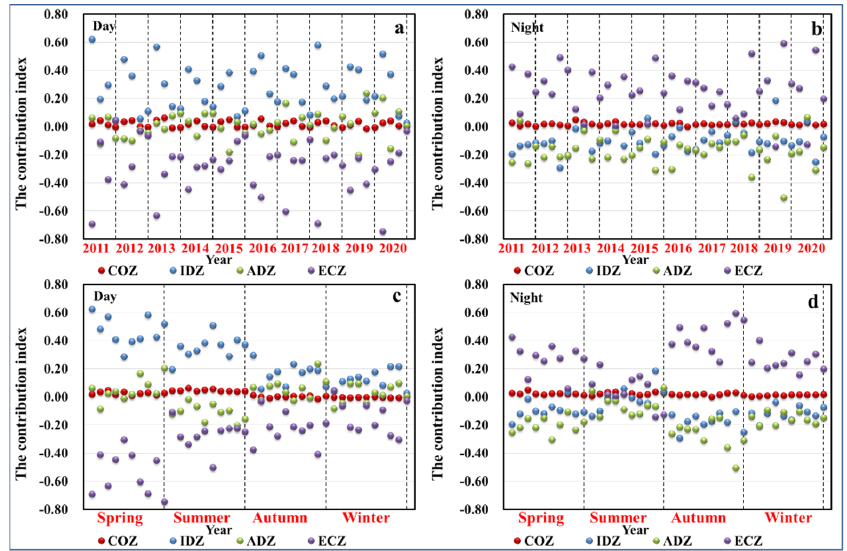
Figure 8. The CI of the MFOZ to the urban thermal environment from 2011 to 2020 (( a , b ) are the CI of MFOZ during daytime and nighttime in different years, respectively; ( c , d ) are the CI of MFOZ during daytime and nighttime in different seasons, respectively).